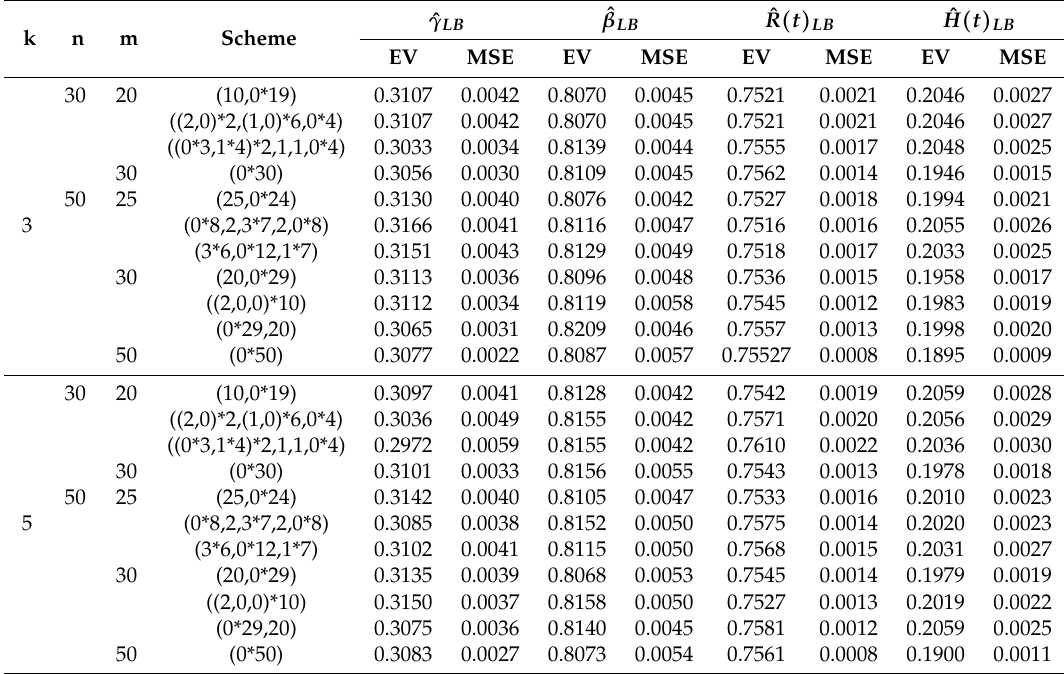
Table 6. Lindley approximation values and MSEs of parameters and reliability and hazard functions under LLF when h = 0.5, γ = 0.3, β = 0.8, t = 1.5, a 1 = 1.08, b 1 = 3.6, a 2 = 16, b 2 = 20, R ( t ) = 0.7563, H ( t ) = 0.1786, N = 1000.